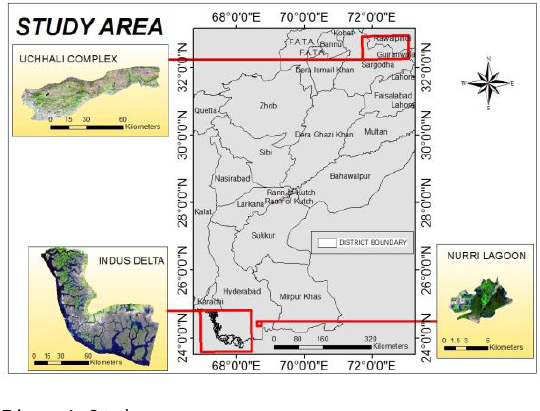
Figure 1. Study area